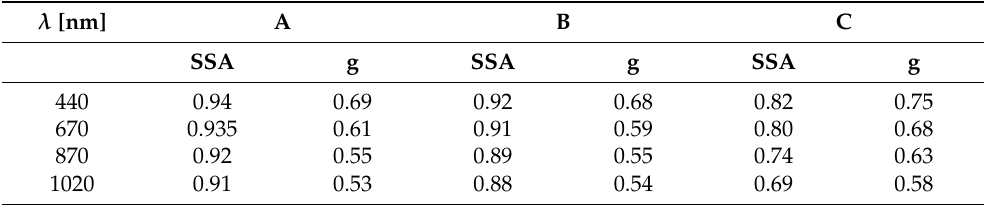
Table 1. Summary of the single scattering albedo (SSA) and asymmetry factor (g) values from: column A = Dubovik et al. [47]; column B = Zhuravleva et al. [48]; column C = Zielinski et al. [24]. See text for